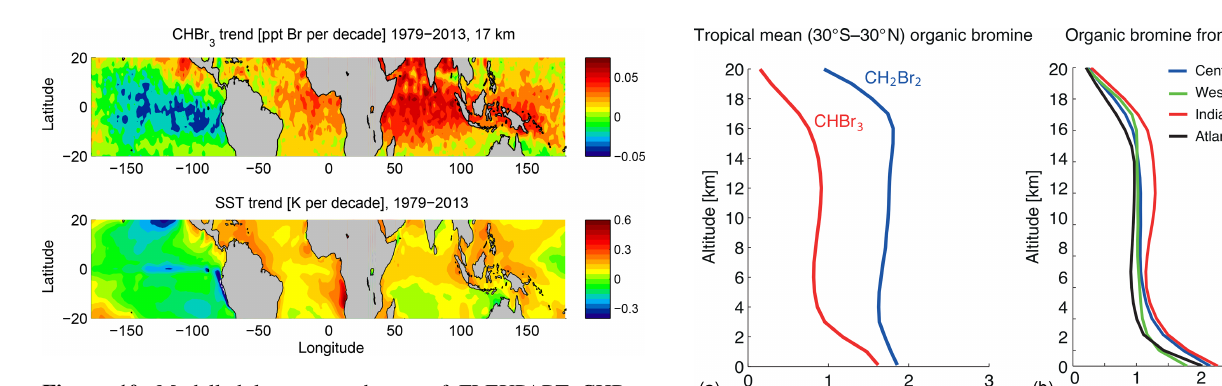
Figure 10. Modelled long-term change of FLEXPART CHBr 3 (pptBr per decade) at 17km and ERA-Interim sea surface temper- ature (SST) (K per decade) for the time period 1979–2013.